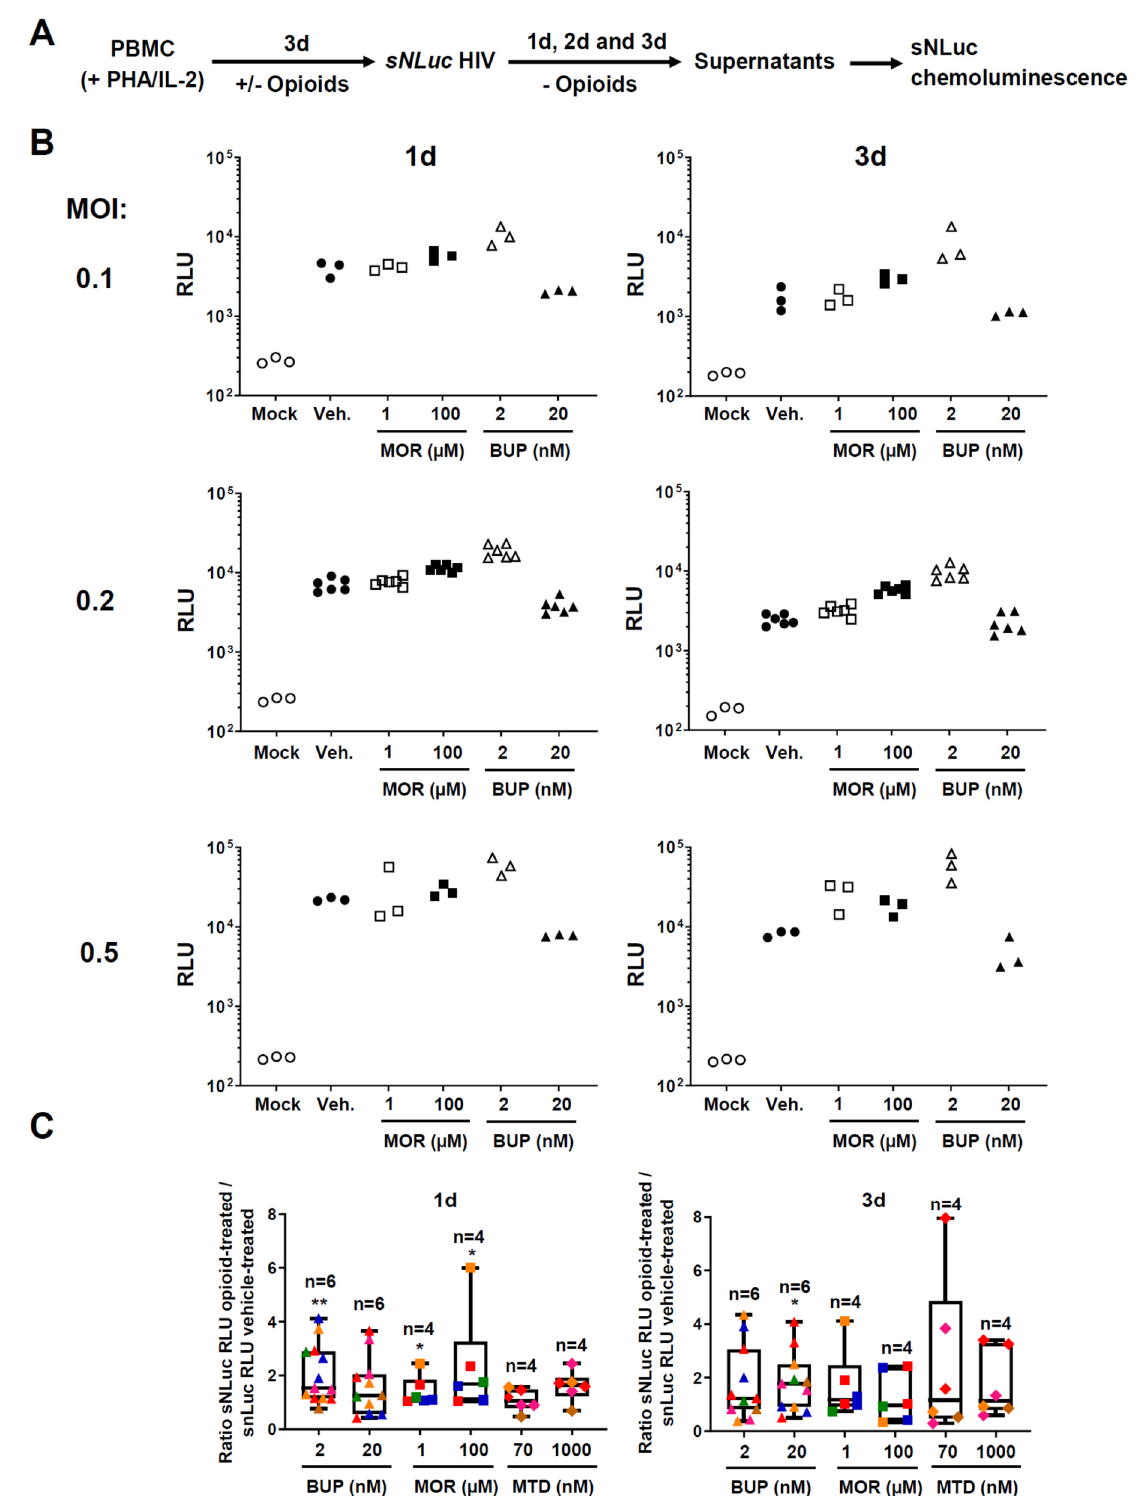
Figure 3. Comparison of the effects of different doses of morphine, buprenorphine and methadone during early HIV-1 infection of PBMC. ( A ) Experimental approach to assess in vitro HIV-1 infection and replication. PBMC were incubated with opioids for 72 h and after infection and washes, drugs were withdrawn. Aliquots were taken at the indicated timepoints, and HIV-1 replication was measured by quantifying nanoluciferase enzymatic activity in the supernatants. Chemiluminescence signals were quantified using a luminometer. ( B ) Representative nanoluciferase experiment done with PBMC from one donor. We cultured PBMC for up to 72 h with PHA/IL-2 and morphine (1 or 100 µ M), buprenorphine (2 or 20 nM), or